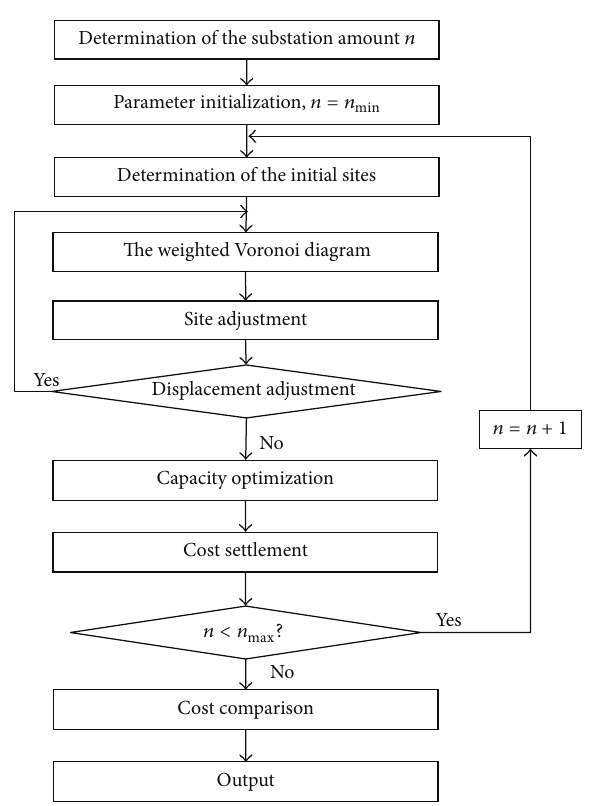
Figure 2: Substation siting by the improved weighted Voronoi